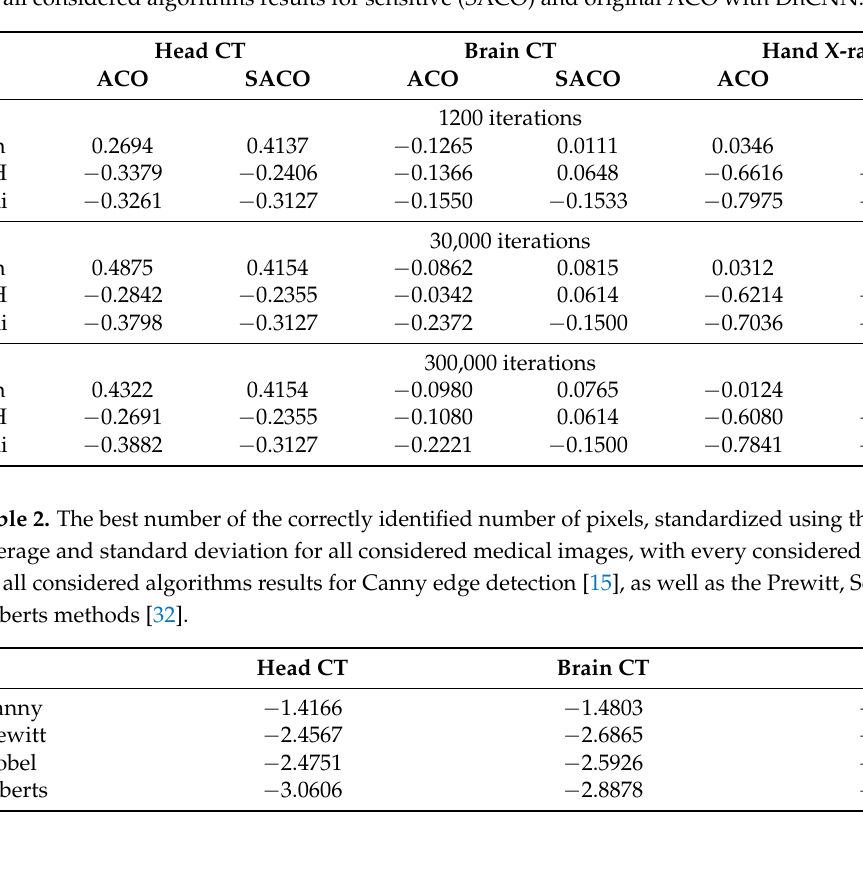
Table 1. The best number of correctly identified number of pixels, standardized using the overall average and standard deviation for all considered medical images, with every considered operator on all considered algorithms results for sensitive (SACO) and original ACO with DnCNN.